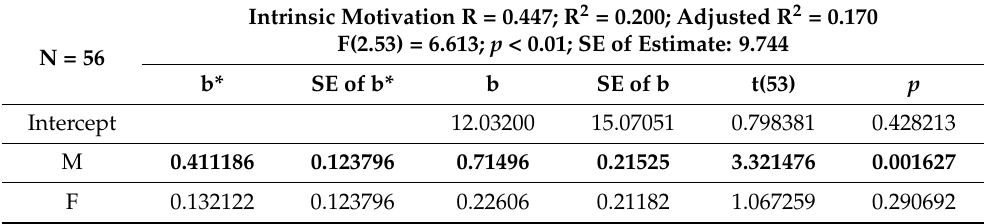
Table 5. Multiple regression explaining variation in intrinsic motivation based on psychological femininity and masculinity in the group of male respondents.